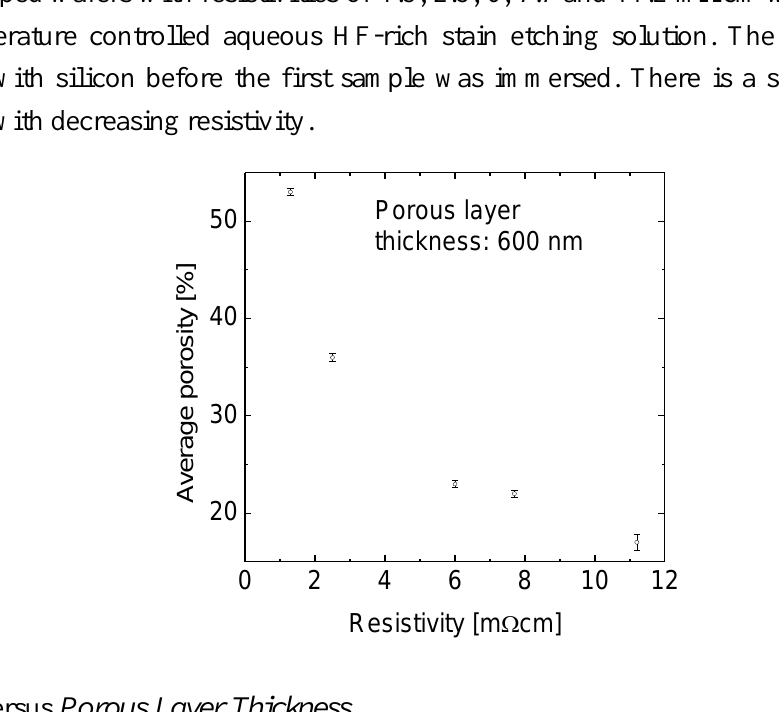
Figure 1. The average porosity as a function of the resistivity of the Si substrate wafer. The p-type doped wafers with resistivities of 1.3, 2.5, 6, 7.7 and 11.2 m  cm were immersed in the temperature controlled aqueous HF-rich stain etching solution. The etching